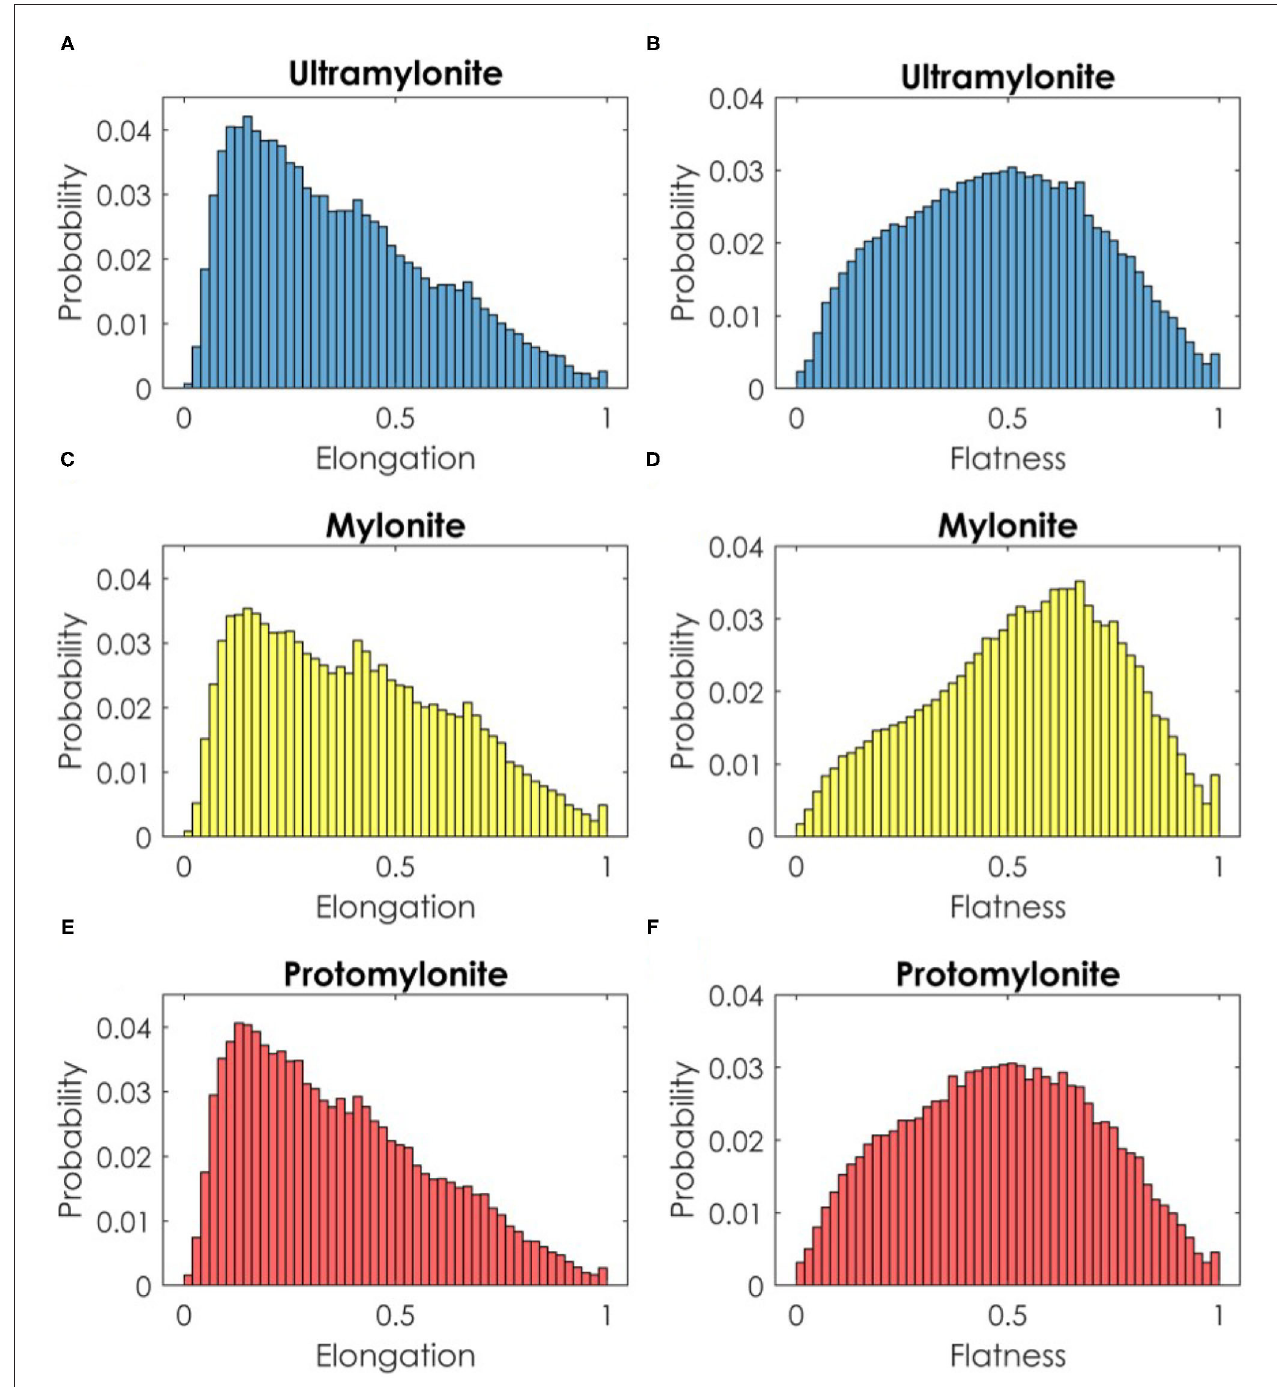
FIGURE 6 | Histograms of pore elongation and flatness in (A,B) ultramylonite, (C,D) mylonite, and (E,F)